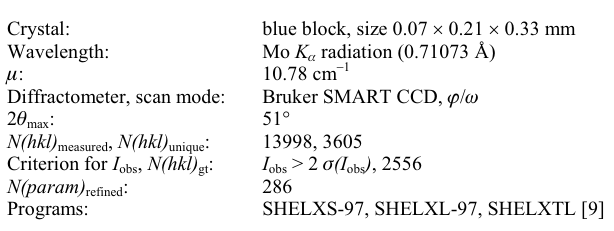
Table 1. Data collection and handling.